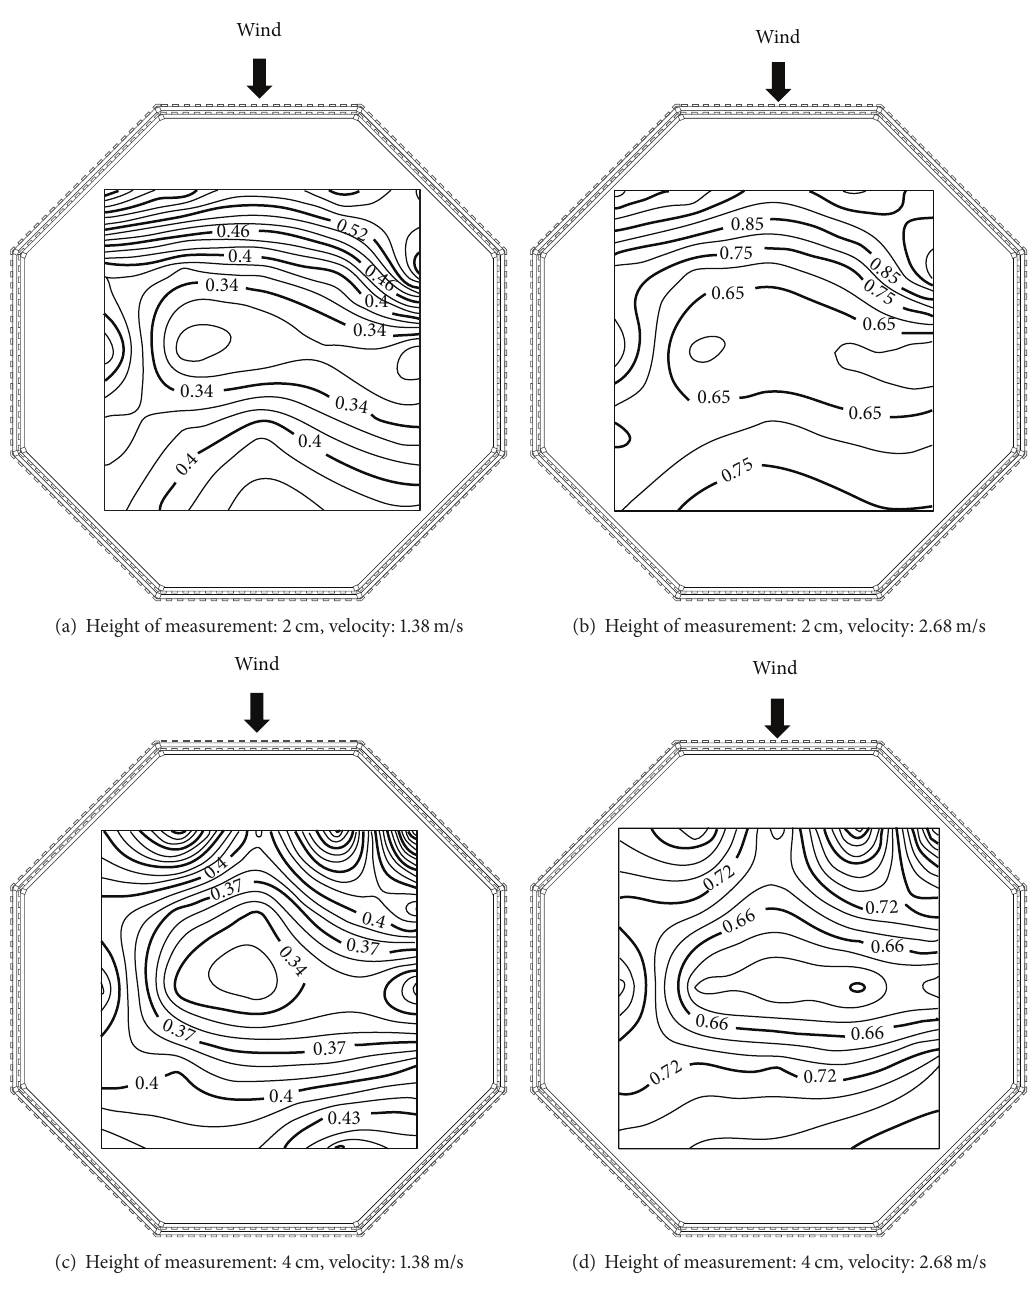
Figure 17: Distribution of wind velocity within the windbreak (CASE